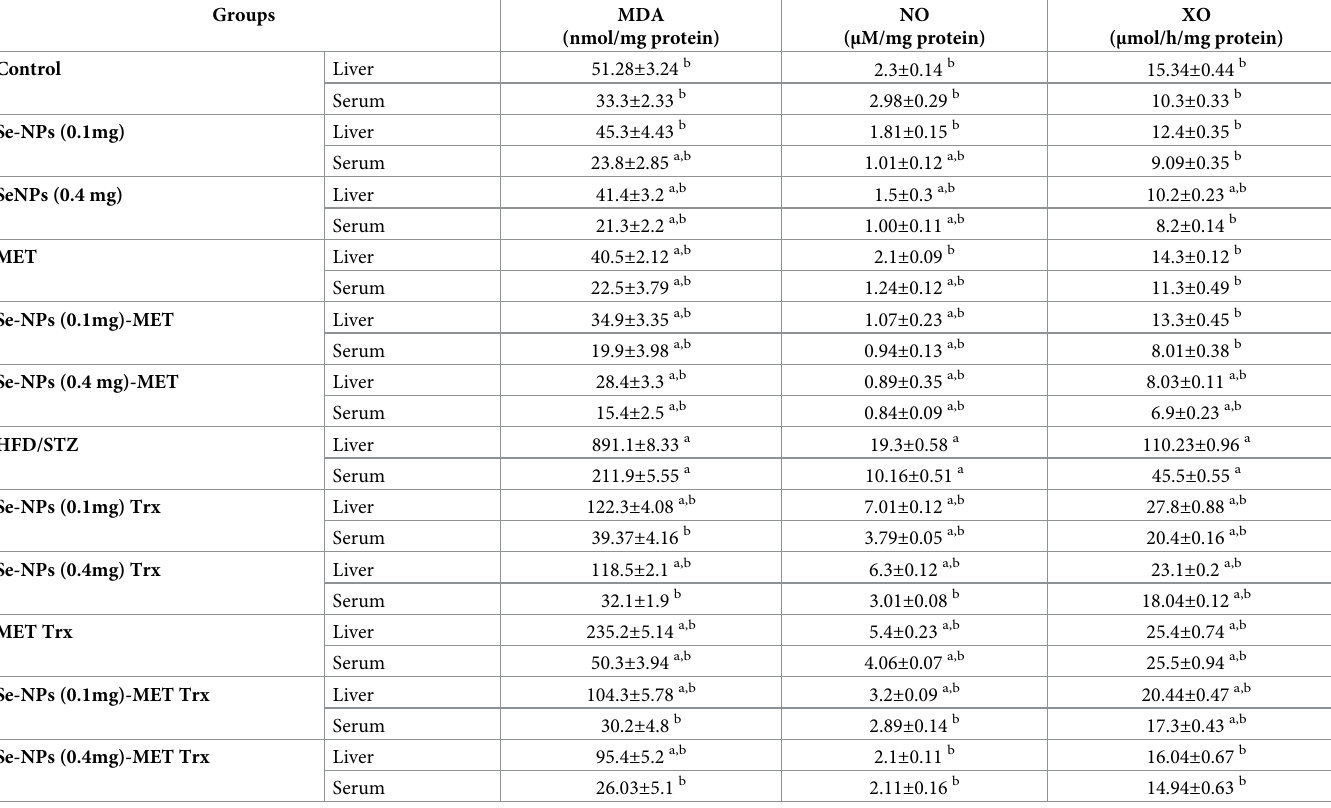
Table 6. Changes in oxidative stress markers [MDA, NO, and XO] in serum and liver tissue of HFD/STZ-induced rats and after treatment with Se-NPs, MET mono- therapy, and combined therapy.